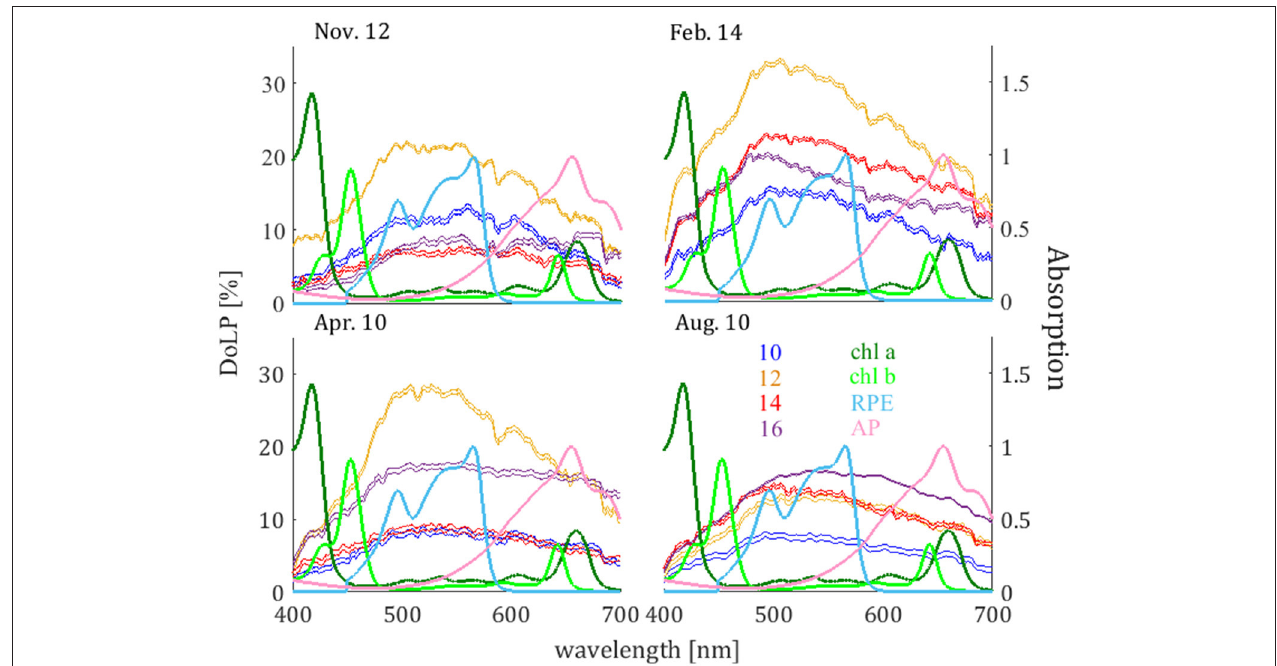
FIGURE 3 | DoLP as obtained from the spectrophotometer method on November 12th 2015, February 14th, 2016, April 10th, 2016, and August 10th, 2016. The dates of each measurement are indicated along the horizontal axis. The time of each measurement is indicated by the color legend. Absorption spectra of chlorophyll a, chlorophyll b, R-phycoerythrin (R-PE), and allophycocyanin (AP), are indicated in the color legend.